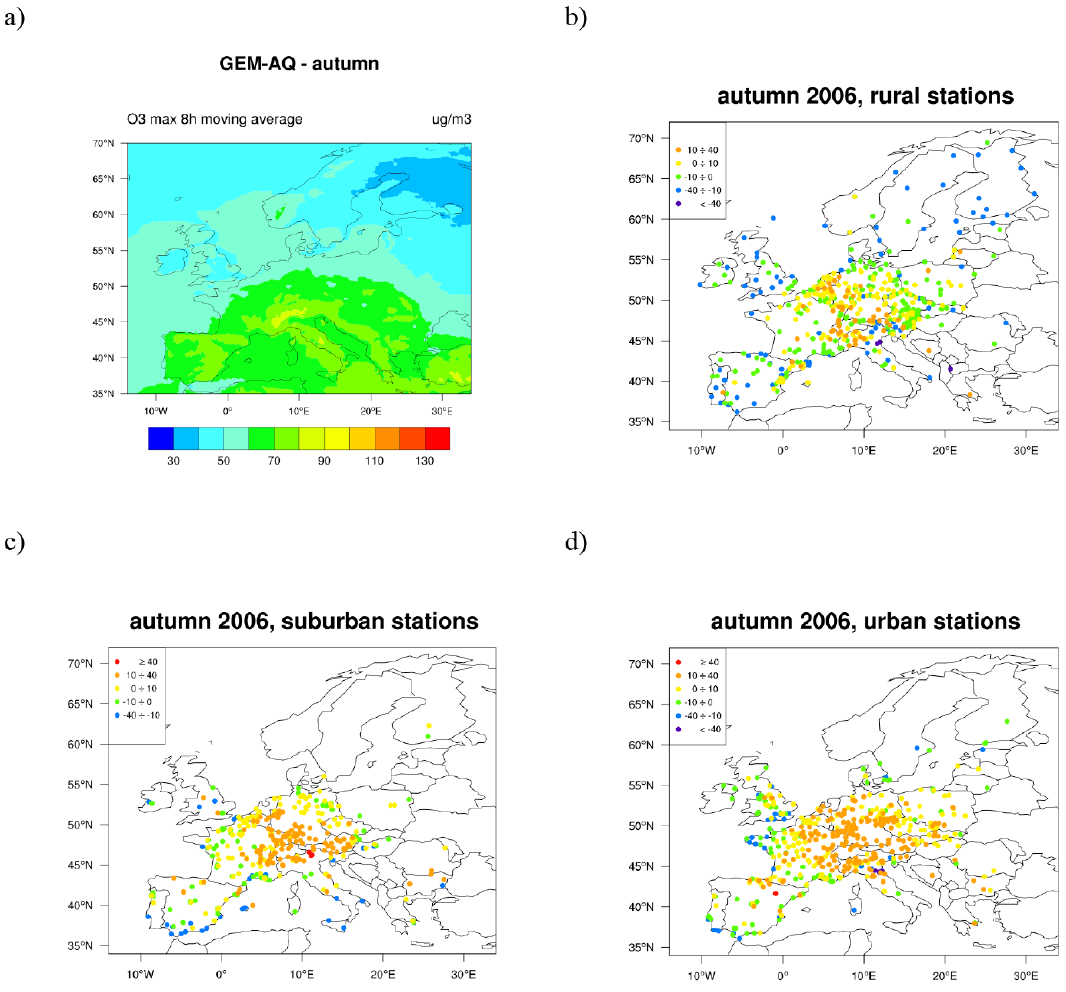
Figure 6. Autumn (SON) maximum 8h running average ozone concentration in µgm − 3 (a) , MBE at rural stations (b) , MBE at suburban stations (c) and MBE at urban stations (d)